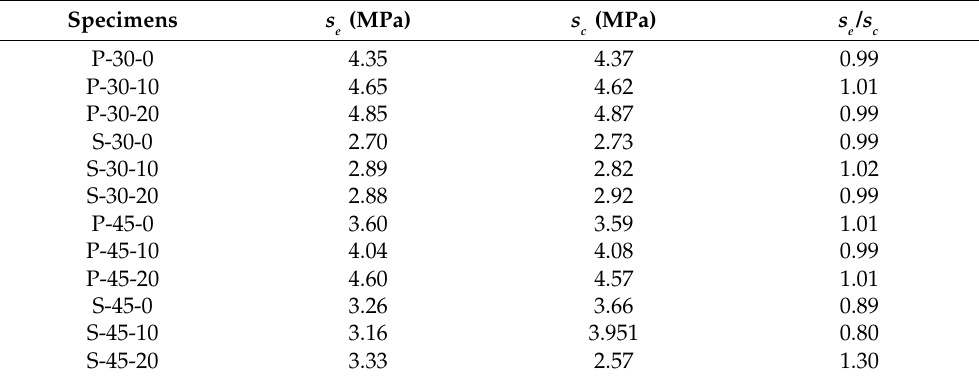
Table 6. Contrast between bond strength experimental values ( s values ( s c